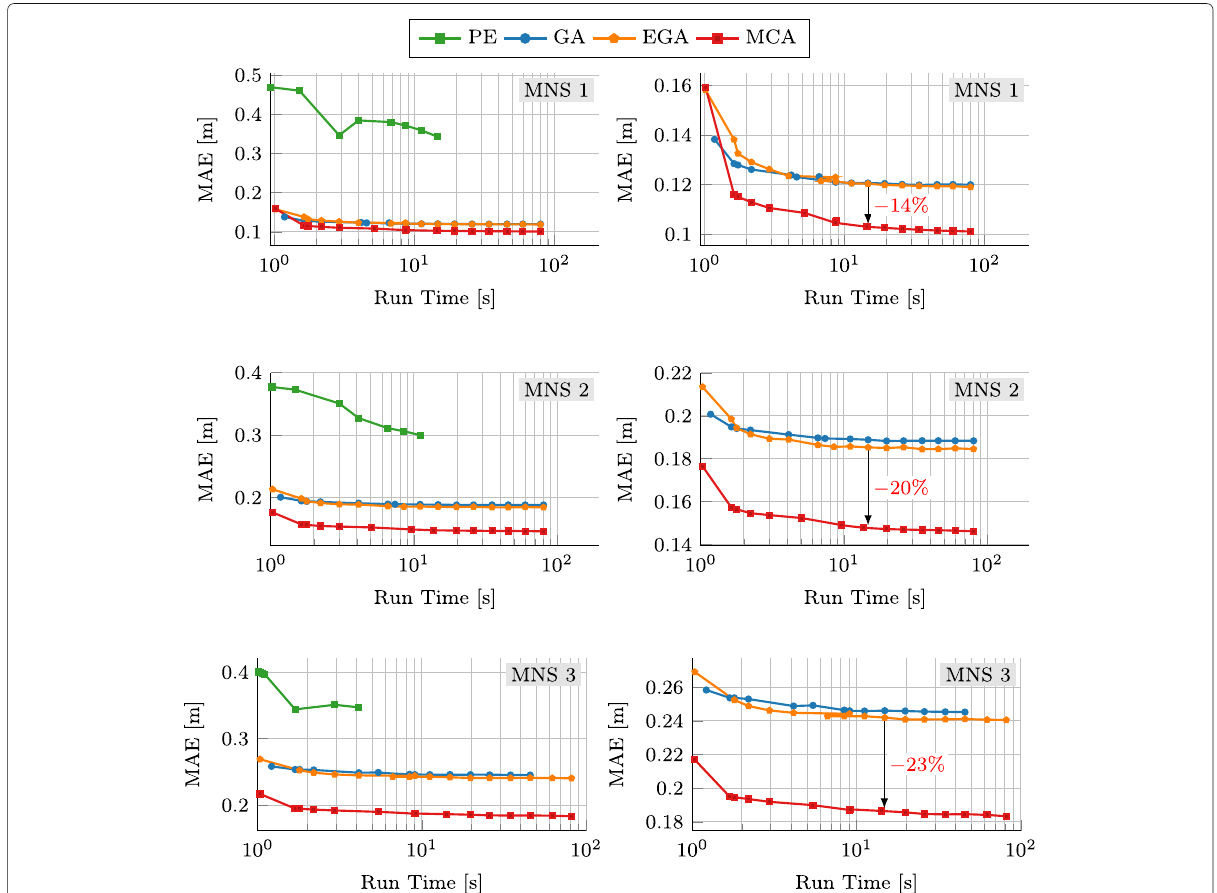
Fig. 5 Localization error as a function of run time. The plots for MNS 1 and MNS 2 are at the top and bottom, respectively. In both MNSs, M = 4 agents are considered. The right panels show magnified views of the results presented in the upper panels but without the PE results for improved